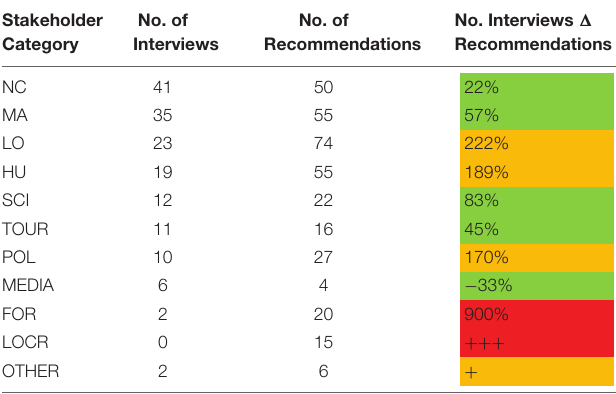
TABLE 5 | Quantitative comparison of interviews and recommendations for further involvement by stakeholder category (on European